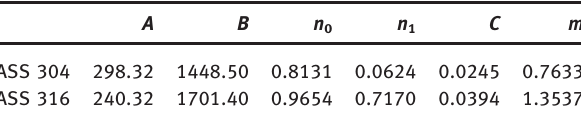
Table 4: Presence of serrations in flow stress curves (DSA) for ASS 304 and 316.